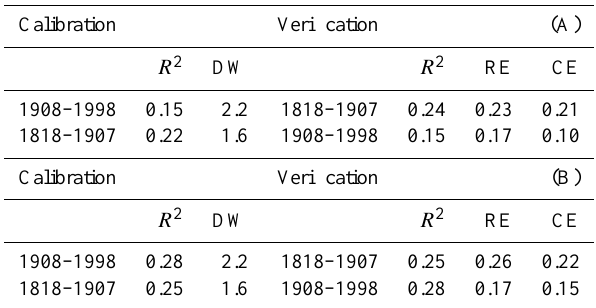
Table 4. Statistical verification of the two JJA temperature recon- structions, performed by computation of RE, CE, R 2 and DW, after regression (A) and scaling